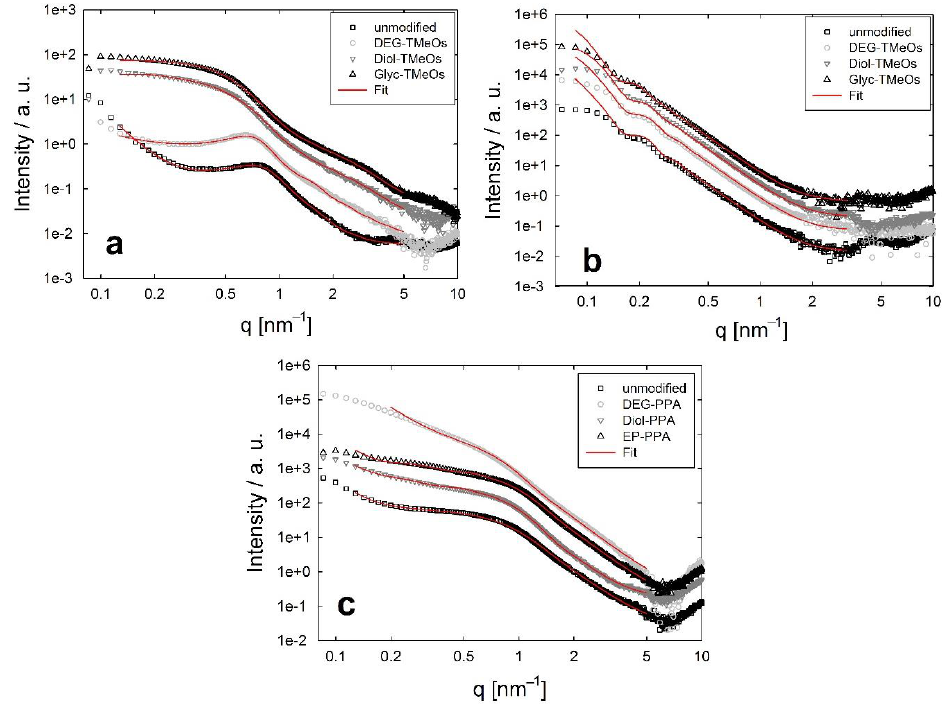
Figure 6. SAXS scattering curves, exemplarily shown for 5 wt% inorganic nanofiller content of epoxy resin nanocomposites containing ( a ) small SiO 2 , ( b ) large SiO 2 , and ( c ) ZrO